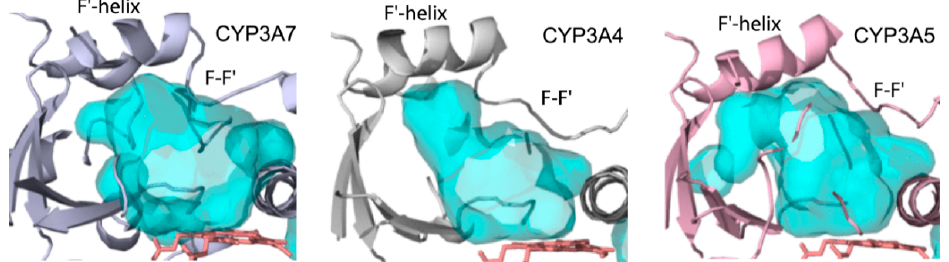
Figure 9. Differently shaped active site cavities in CYP3A enzymes.